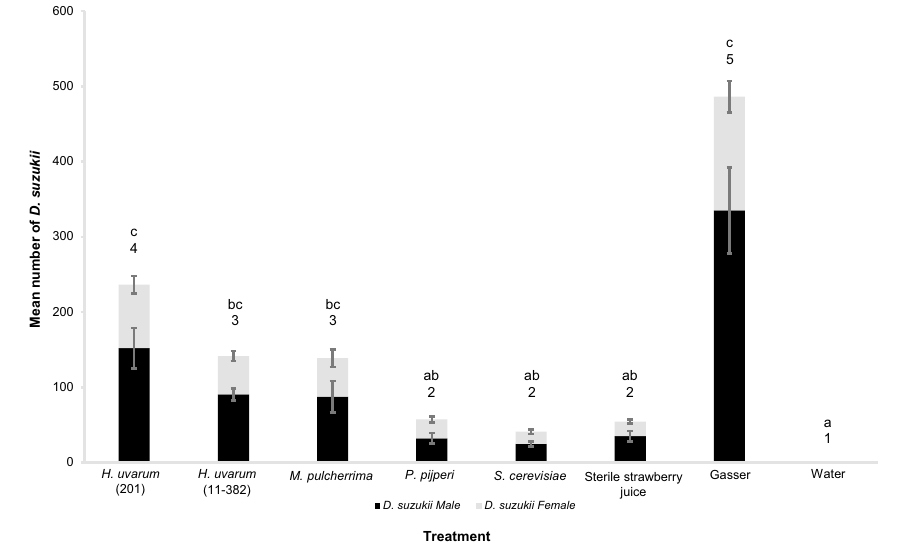
Figure 3. Mean numbers (± SE) of D. suzukii caught in field traps over a 72-h period baited with metabolic volatiles (not identified) from five different yeasts after individual growth in strawberry juice; sterile strawberry juice, water and commercial Gasser-lure are controls (N = 6). There was a significant effect of bait type on numbers of D. suzukii caught (linear model Δ deviance = 6434, df = 7, P < 0.001; Kruskal–Wallis, chi- squared = 41.59, df = 7, P = 0.62 –7 ). Two post-hoc analysis methods were employed: letters above bars connect treatments that are not significantly different using Dunn’s comparisons with Benjamini–Hochberg adjusted P values, and numbers above bars connect treatments with overlapping 95% confidence intervals calculated from Estimated Marginal